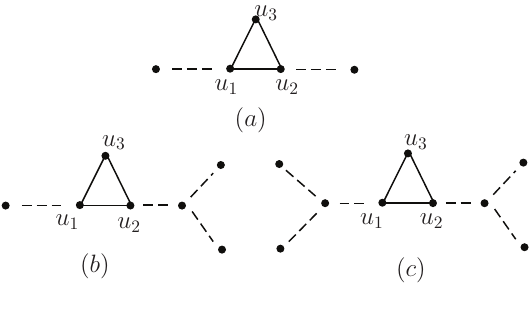
Figure 6: The graph class